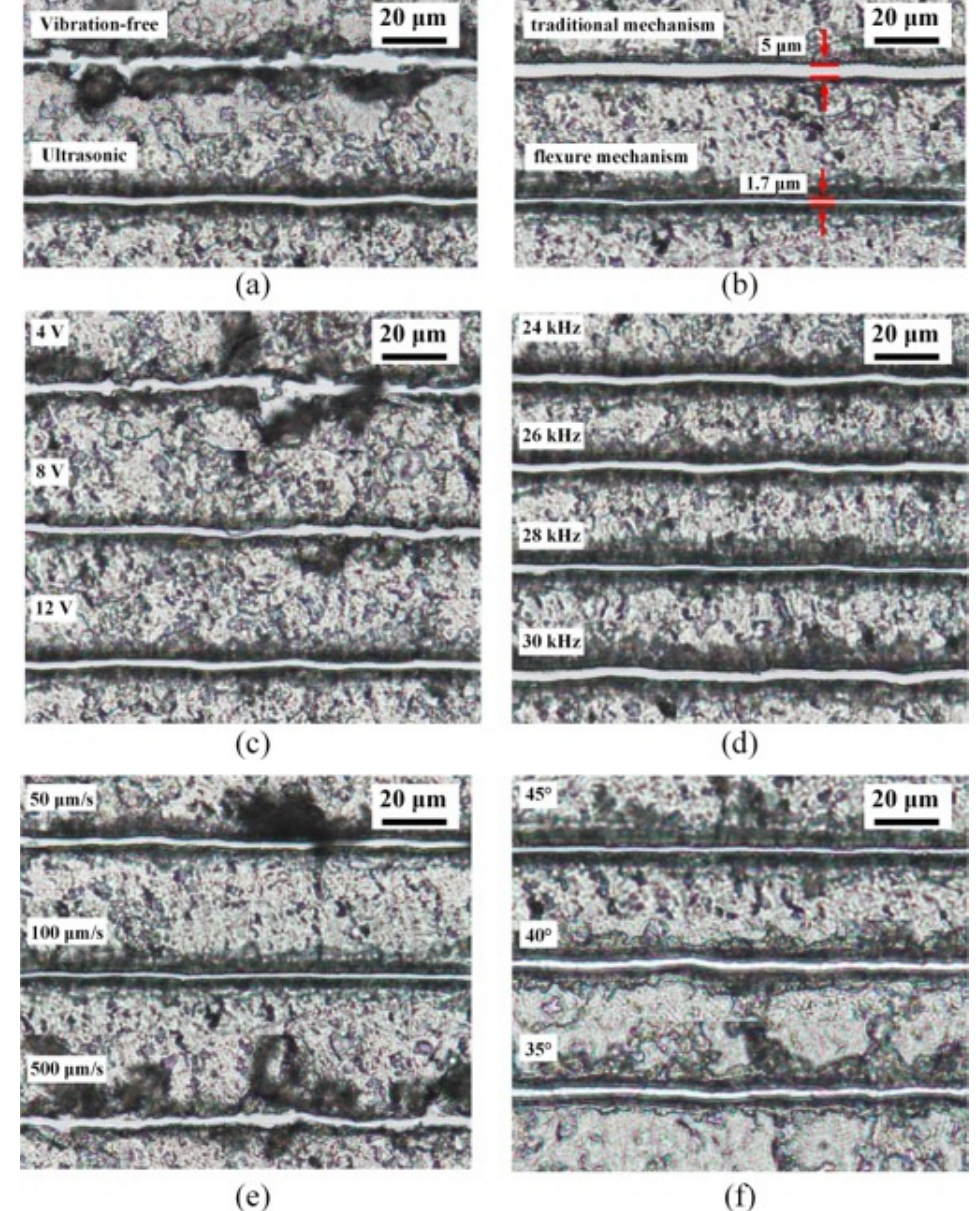
Figure 10. Experimental results of tissue section dissection under different dissecting parameters: ( a ) different dissecting methods; ( b ) dissecting effect of two structures; ( c ) different drive voltages; ( d ) different drive frequencies; ( e ) different feed speeds; ( f ) different dissecting angles. Next, the ultrasonic vibration dissecting method was used to dissect the tissue